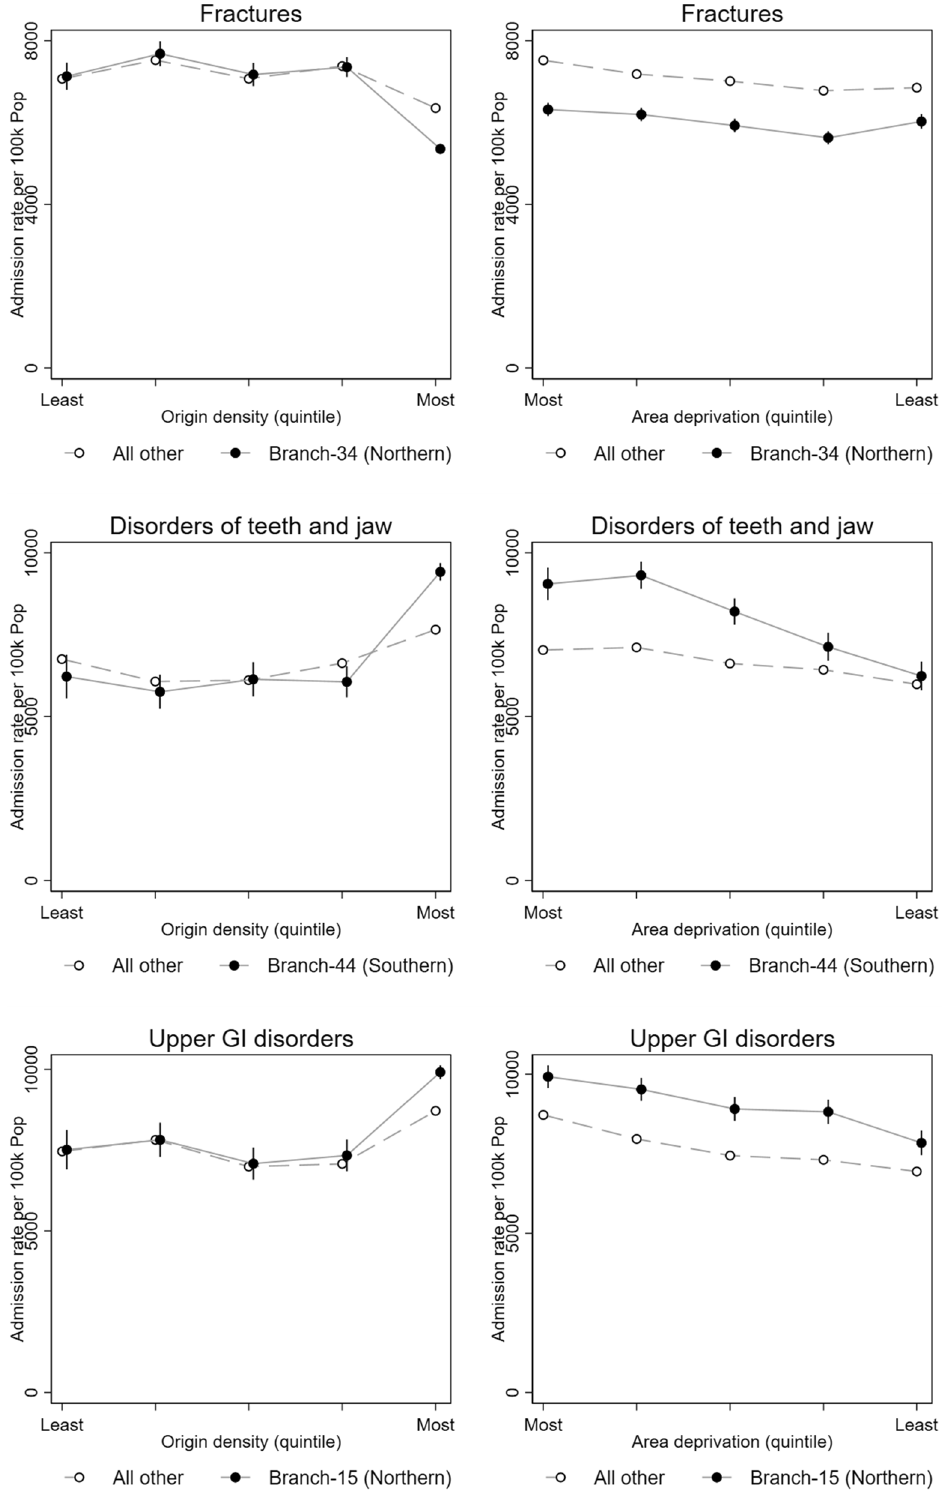
Figure 3. Admission rate by origin density and area deprivation